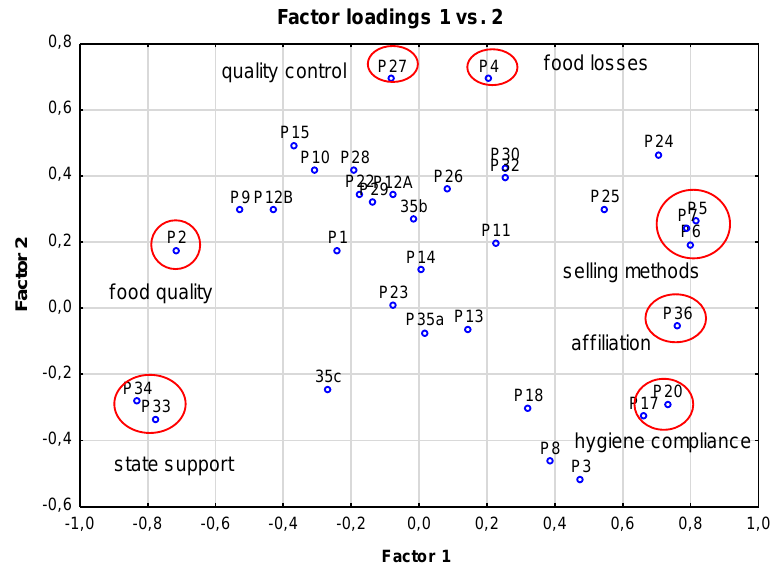
Figure 7. Principal component analysis conducted for most of the variables.